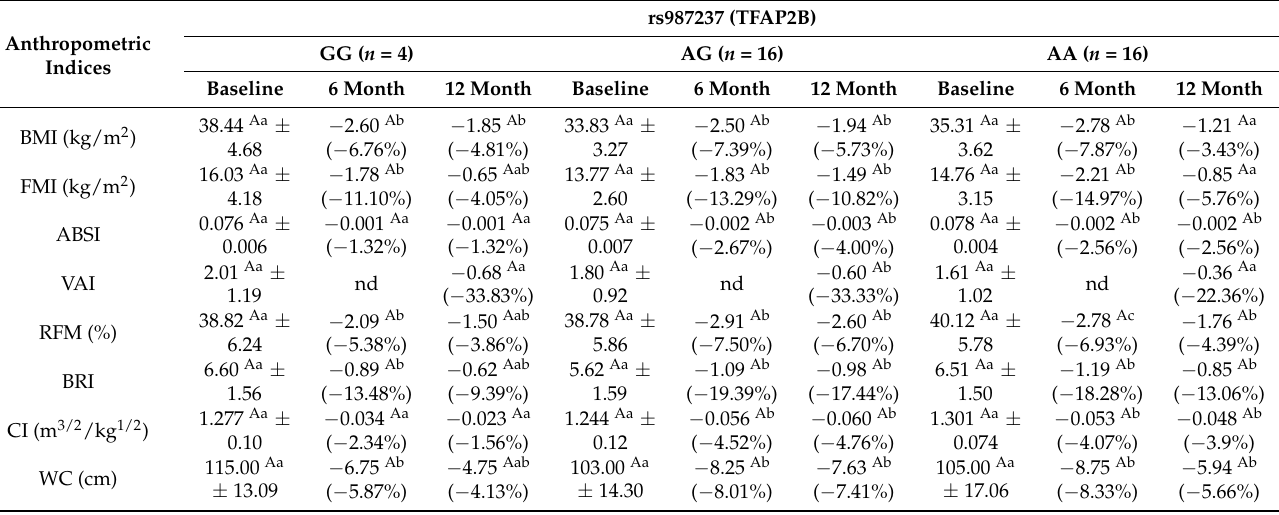
Table 6. Differences in changes in the anthropometric indices, depending on TFAP2B